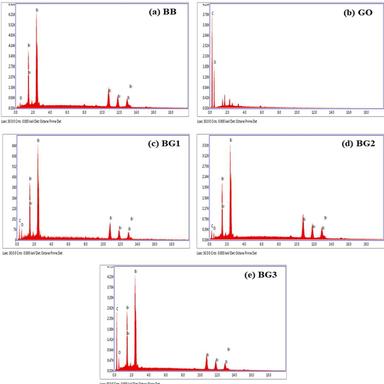
EDAX spectrum (a) BB, (b) GO, (c) BG1, (d) BG2 and (e) BG3 nanomaterials.